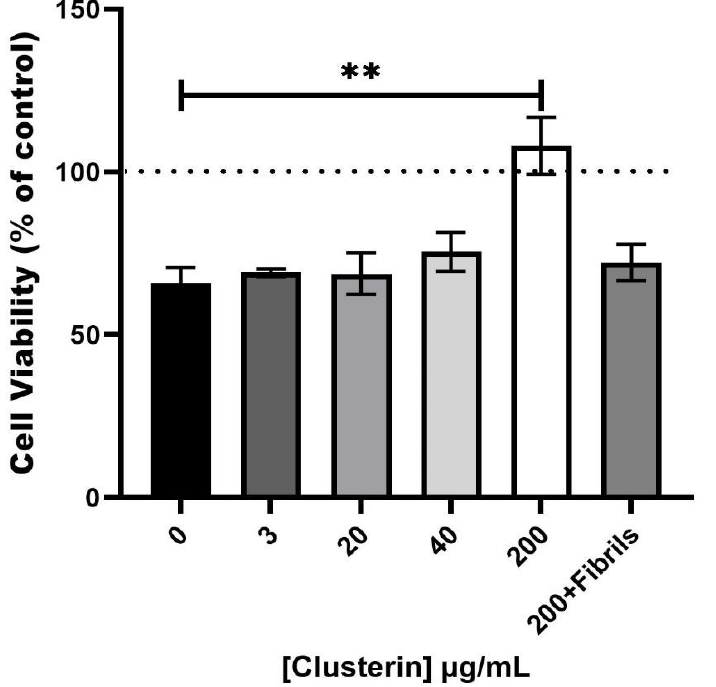
Figure 3. Effect of clusterin on the toxicity towards PC-12 cells of 2 mg/mL (439 µ M) PAP248–286. The peptide was dissolved in 200 mM phosphate buffer, pH 7 and incubated at 37 ◦ C for 48 h with different concentrations of clusterin (3, 20, 40 and 200 µ g/mL corresponding to 0.050, 0.333, 0.666 and 3.33 µ M, and hence molar ratios of PAP248–286:clusterin monomer of 8788:1, 1318:1, 659:1 and 132:1 respectively). In a separate experiment, 200 µ g/mL of clusterin was added to preformed SEVI fibrils and incubated for 48 h (200+Fibrils). Samples were then added to the culture media of PC-12 cells and incubated for 48 h. The MTT assay was used to assess cell viability and values are presented as percentage of cell survival compared to control. Results are expressed as mean ± standard error of three independent experiments. (** One-way ANOVA, p < 0.01).